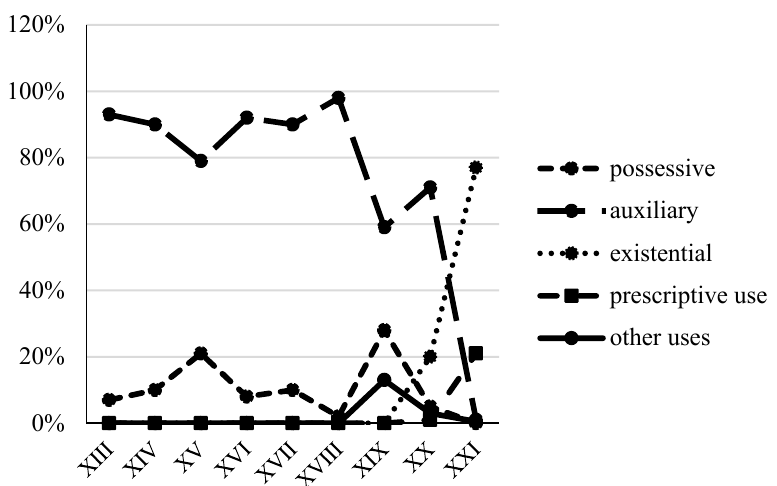
Figure 1. Meaning of habemos ( avemos ). Refunctionalization.